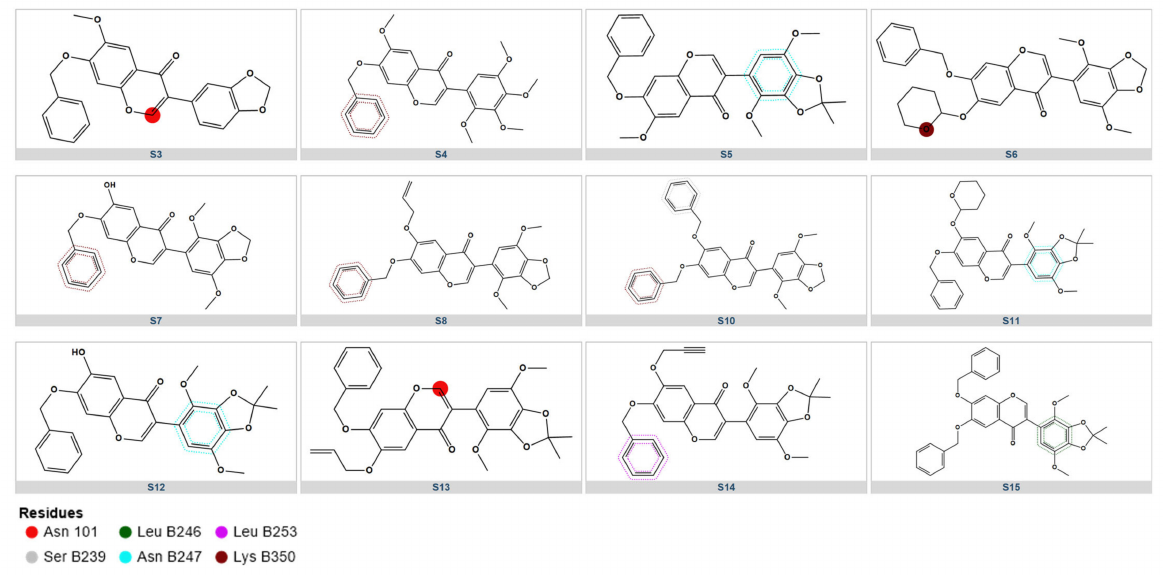
Figure A1. Summary of the interactions of gatastatin derivatives with α - β III.